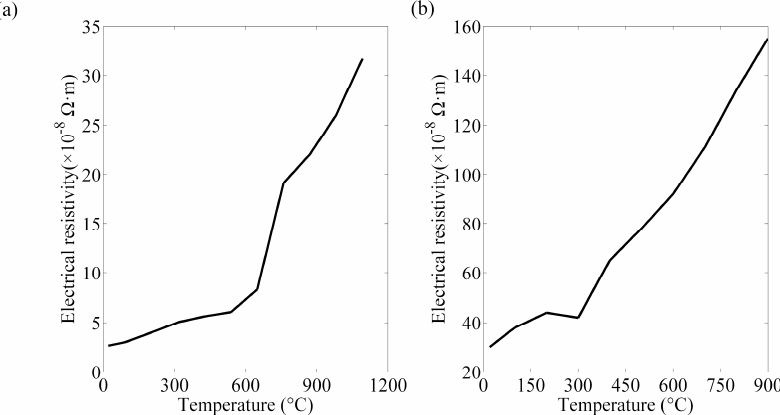
Figure 5. Resistivity of the electrode ( a ) and DP600 ( b ).